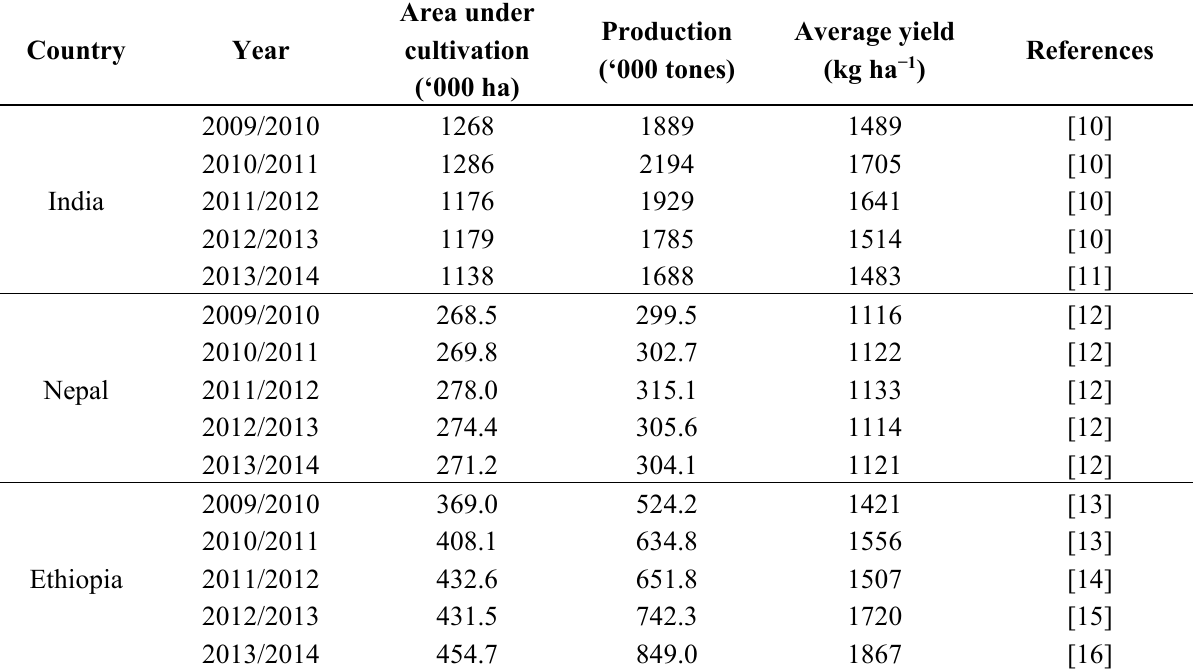
Table 1. Production data for finger millet in selected major finger millet producing nations